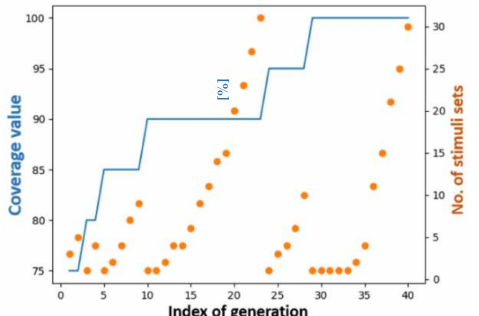
Figure 9. Representation of coverage fulfillment process using best performing approach,